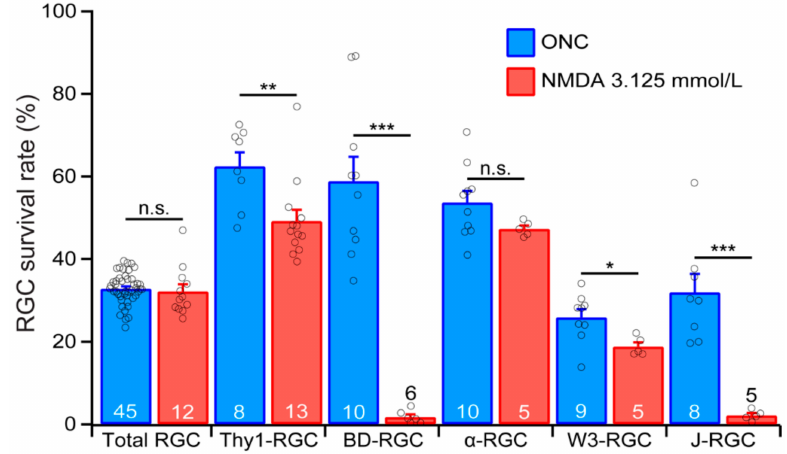
Figure 7. RGC survivability varies depending on the type of injury. A comparison of the survival rates of Thy1-RGCs, BD-RGCs, α RGCs, W3-RGCs, and J-RGCs after either ONC (blue) or NMDA excitotoxicity (red). Both insults induced a similar loss of total RGC labeled by the anti-RBPMS antibody. However, their e ff ects on di ff erent RGC types are drastically di ff erent. The t -test results of survival rates of each RGC type / group after ONC or NMDA excitotoxicity are the following: total RGC, p = 0.6478; Thy1-RGC, p = 0.0066, BD-RGC, p < 0.0001; α -RGC, p = 0.1419; W3-RGC, p = 0.0253; J-RGC, p = 0.0003. The number in each column is n, and the circles are results of individual eyes. n.s.: not significant. * 0.01 < p < 0.05. ** 0.001 < p < 0.01. *** p <